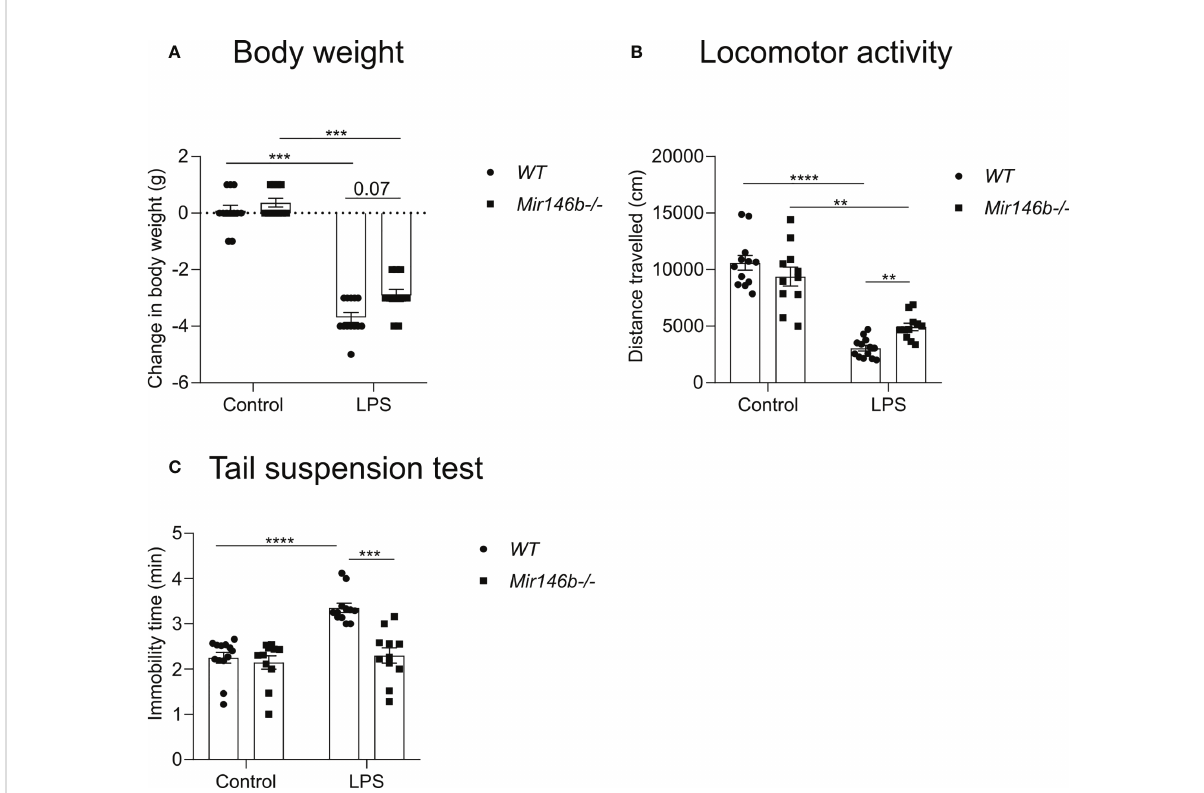
FIGURE 3 miR-146b de fi cient mice have reduced sickness behavior upon LPS challenge. Mice were injected with LPS in saline or equal volume of saline (control) and subjected to sickness behavior tests. (A) Change in body weight, (B) Locomotor activity and (C) Immobility time in tail suspension test was measured. Number of animals = 11-12. Data are represented as mean ± SEM; **p<0.01;***p<0.001; **** p < 0.0001 (Welch ’ s ANOVA with Dunnett ’ s multiple comparisons